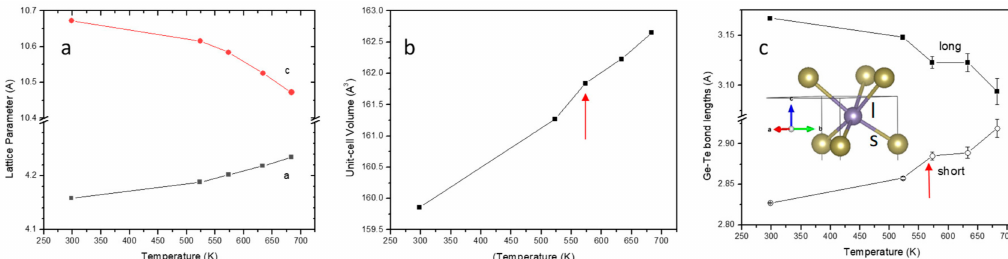
Figure 4. Thermal evolution of ( a ) a and c unit cell parameters in the hexagonal description of the rhombohedral structure, ( b ) unit-cell volume and ( c ) short and long Ge-Te distances of the GeTe 6 octahedra (see Figure 3 at 298 K), from NPD data. The arrow signals an anomaly in volume and bond-length